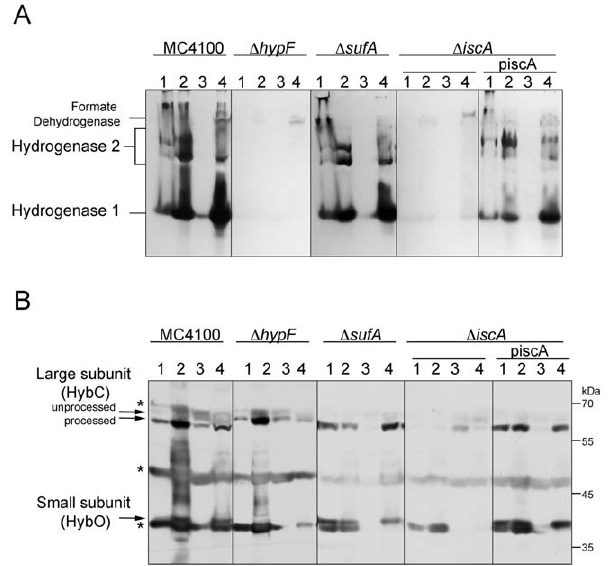
Figure 5. Subcellular localization of hydrogenase 2 in iscA , sufA and erpA mutants. Aliquots (25 m g protein) derived from whole cells (1), crude extracts (2), soluble fractions (3) or membrane fractions (4) from MC4100, DHP-F2 ( D hypF ), CP1223 ( D sufA ), CP477 ( D iscA ) and CP477 + piscA were separated either by native-PAGE (A) (7.5% w/v polyacrylamide) and stained for hydrogenase enzyme activity, or by 10% SDS-PAGE (B) and subjected to Western blotting using anti- hydrogenase 2 antiserum. On the left side of panel A, the migration positions of hydrogenase 1, hydrogenase 2, and of the hydrogenase- independent formate dehydrogenase hydrogen: BV oxidoreductase activity are indicated. In panel B the migration positions of the unprocessed and processed forms of the catalytic subunit HybC and the small subunit HybO are shown. The asterisks indicate unspecifically cross-reacting polypeptides of unknown identity, which acted as internal loading controls. The migration positions of the molecular mass standards (in kDa) are indicated on the right of the Figure.